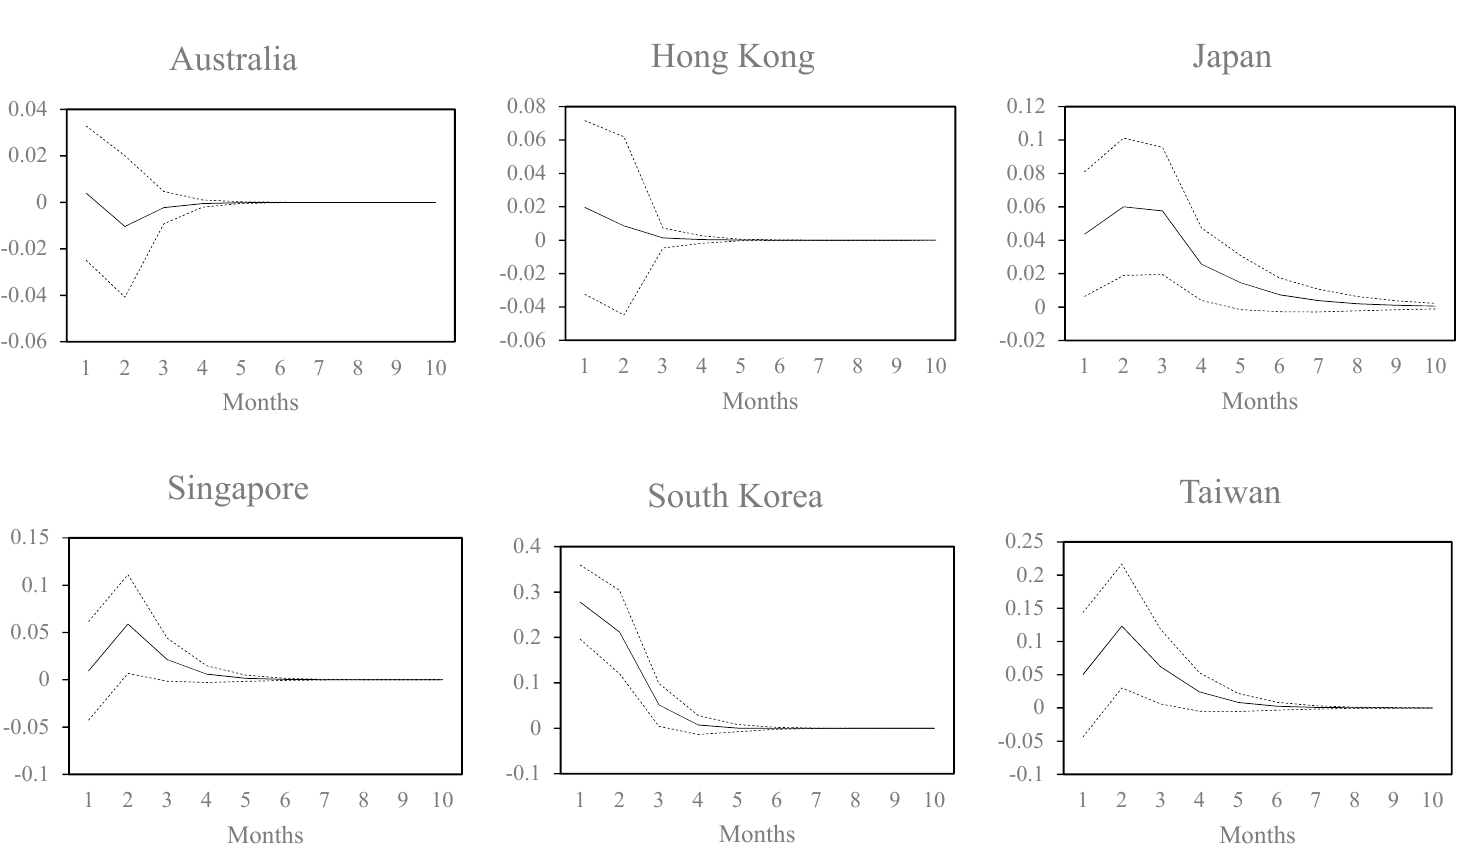
Figure 2. Impulse response functions (IRFs) of TURN to RET with two standard error bands. Note: For each market, the solid line is the impulse response function of TURN to RET following a one ‐ SD RET innovation; the two dashed lines are the confidence bands of two standard errors.